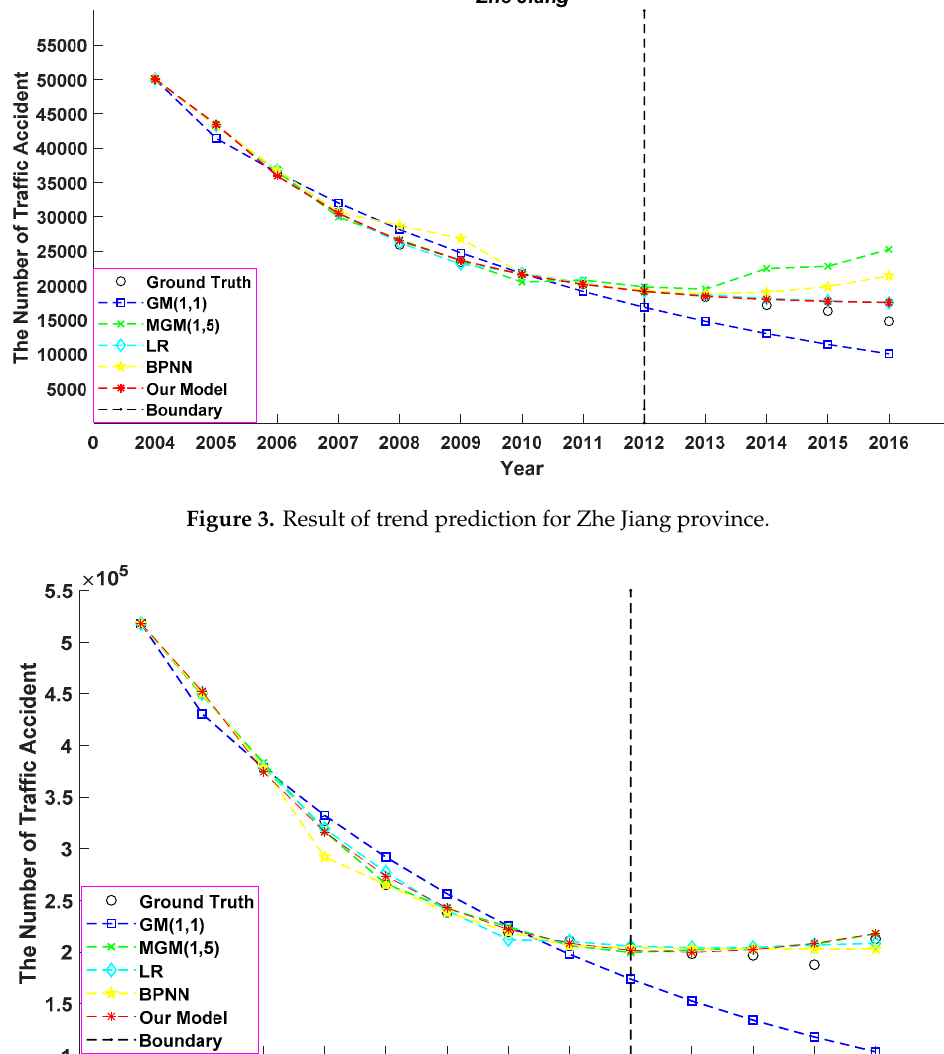
Figure 2. Result of trend prediction for Chong Qing city.